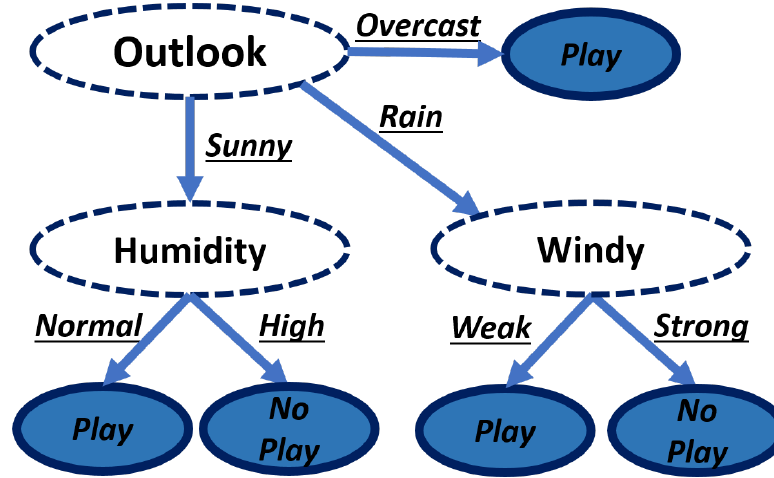
Figure 9. The classifier’s test problem: C4.5 rule tree.